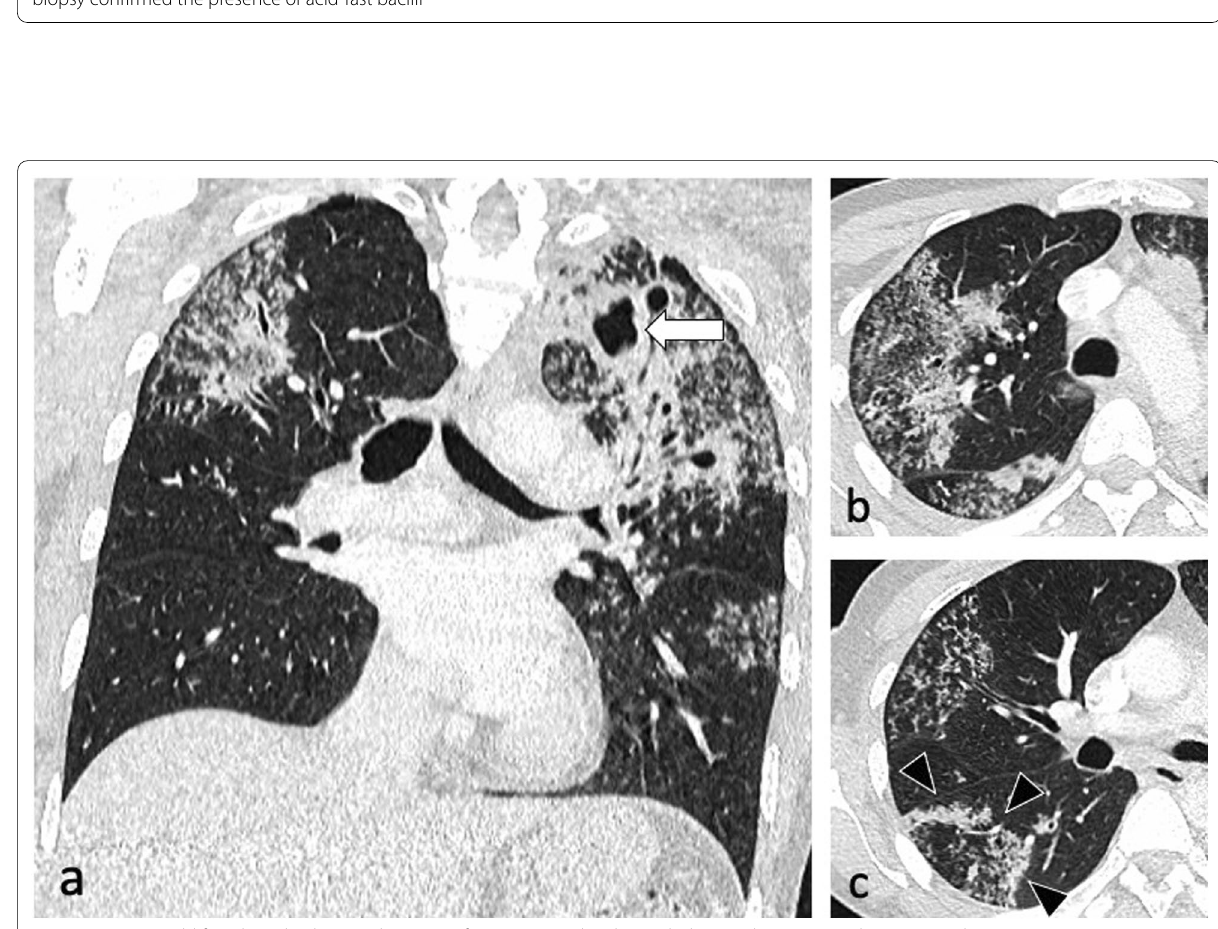
Fig. 9 A 47-year-old female with a known diagnosis of HIV presented with weight loss, night sweats and worsening dyspnoea. Her CD4 count at presentation was 120 cells/mm 3 . CT (lung window) demonstrates thick-walled irregular cavities (coronal plane— a , arrow), extensive bilateral upper lobe centrilobular and tree-in-bud nodules and nodular reversed halo sign in the apical segment of the right lower lobe (axial plane— c ,